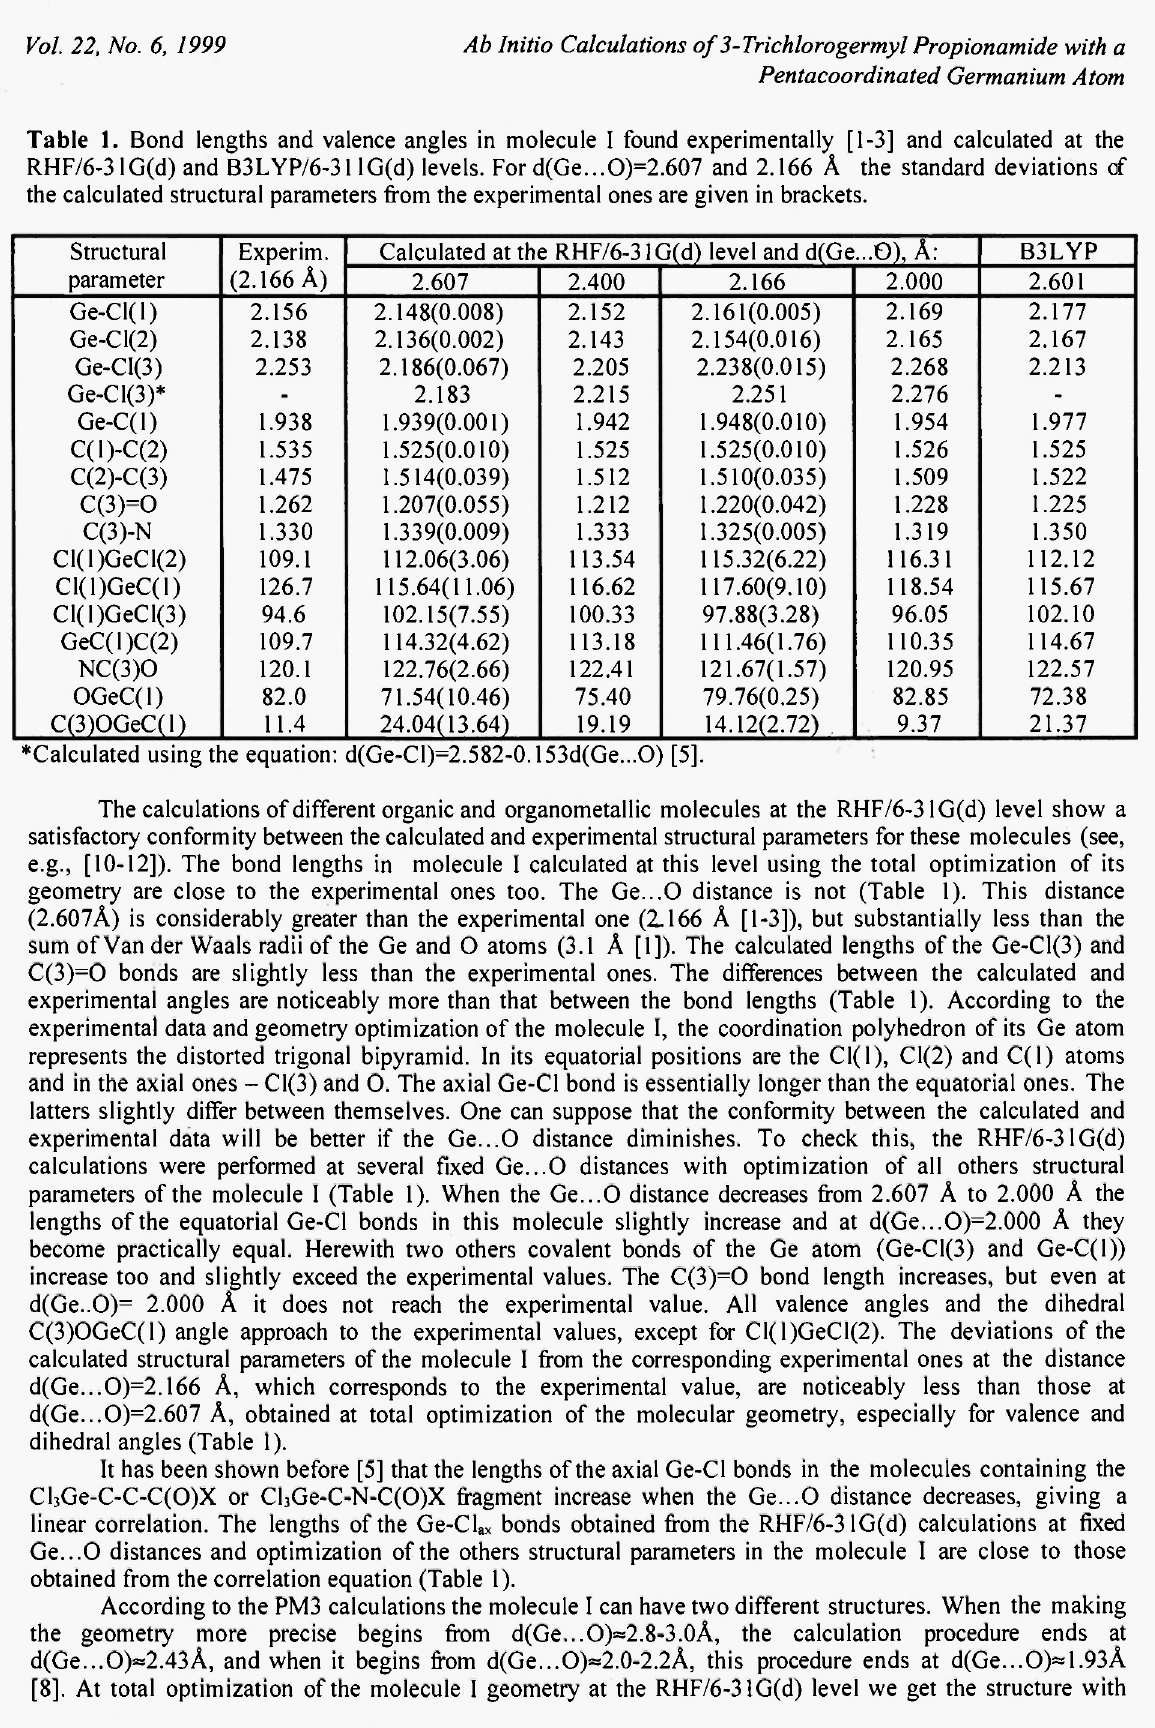
Table 1. Bond lengths and valence angles in molecule I found experimentally [1-3] and calculated at the RHF/6-3lG(d) and B3LYP/6-31 lG(d) levels. For d(Ge,..0)=2.607 and 2.166 A the standard deviations of the calculated structural parameters from the experimental ones are given in